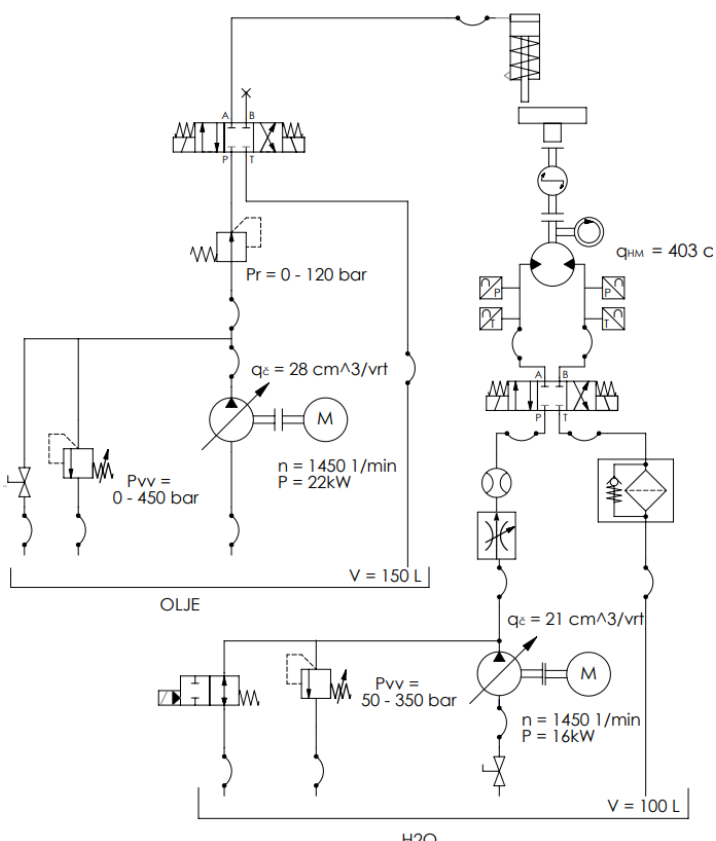
Figure 5. Hydraulic circuit of the test rig for evaluating the performance of the water-orbital hydraulic